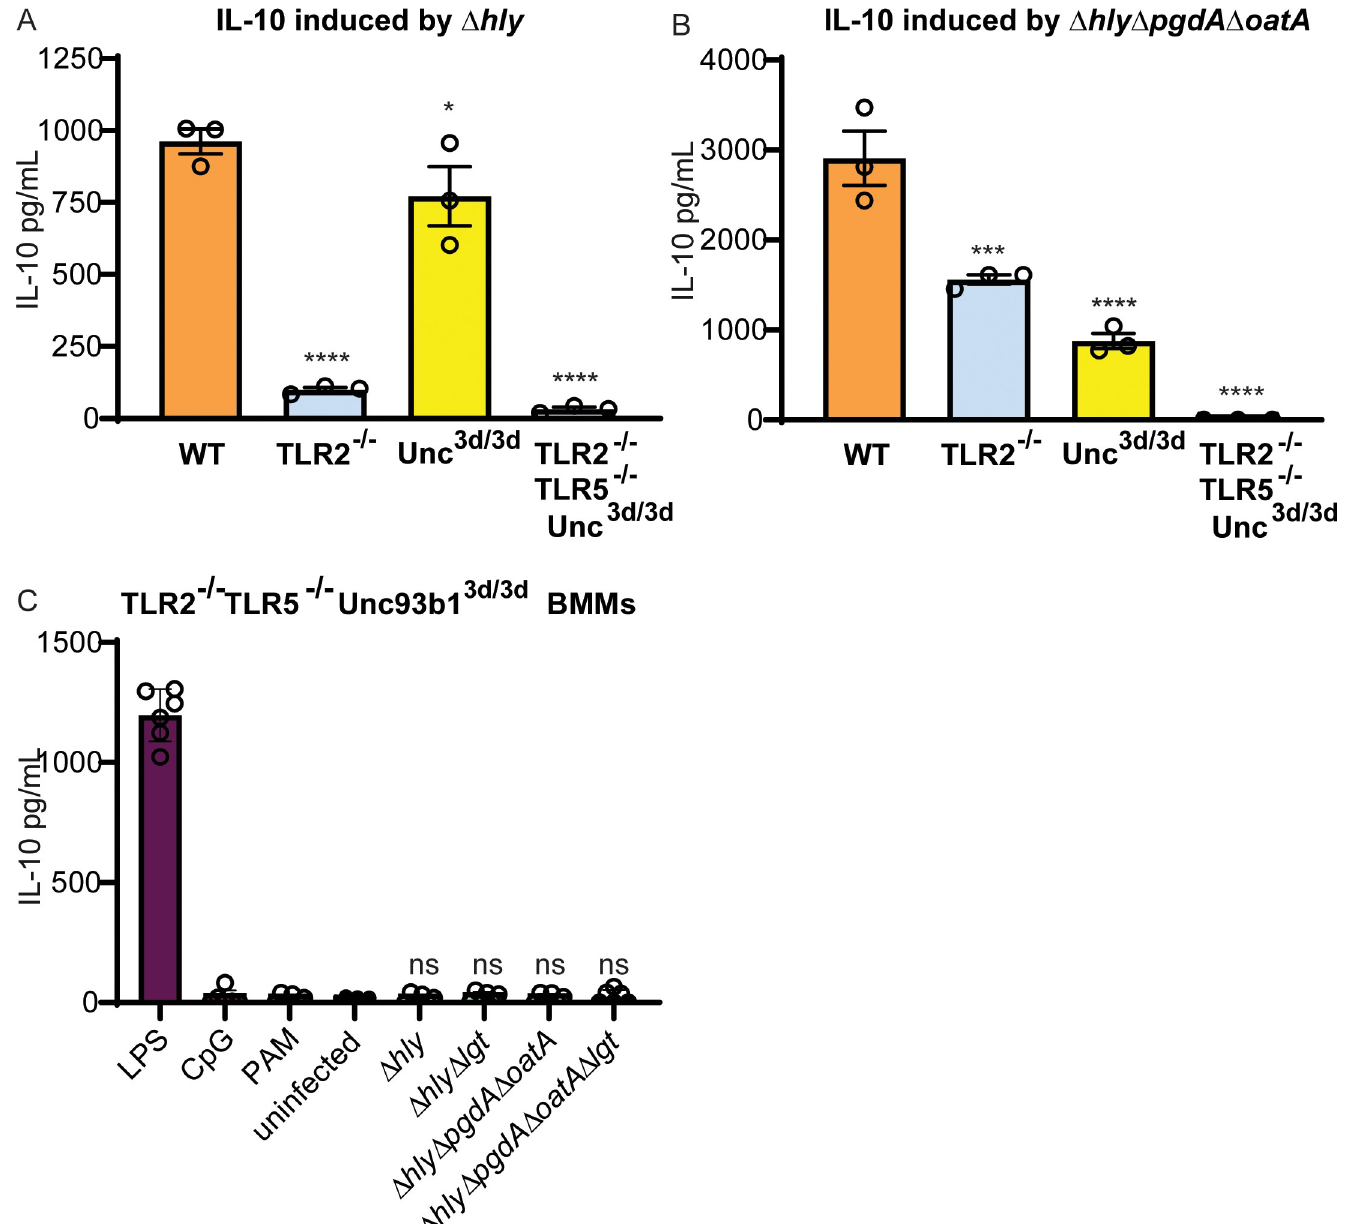
Fig 3. IL-10 secretion from BMMs in response to L . monocytogenes infection requires TLR2 and endosomal TLR signaling. (A) WT, TLR2 -/- , Unc93b1 3d/3d , and TLR2 -/- TLR5 -/- Unc93b1 3d/3d BMMs were infected with Δ hly L . monocytogenes . Cell supernatant was harvested four hours post infection and IL-10 was measured by ELISA. Data shown are representative of two independent experiments. Means were compared to WT using Holm-Sidak’s Multiple Comparisons test. (B) WT, TLR2 -/- , Unc93b1 3d/3d , and TLR2 -/- TLR5 -/- Unc93b1 3d/3d BMMs were infected with Δ hly Δ pgdA Δ oatA L . monocytogenes . Cell supernatant was harvested four hours post infection and IL-10 was measured by ELISA. Data shown are representative of two independent experiments. Means were compared to WT using Holm-Sidak’s Multiple Comparisons test. (C) TLR2 -/- TLR5 -/- Unc93b1 3d/3d BMMs were infected with the indicated strains of L . monocytogenes , or treated with lipopolysaccharide (LPS), a TLR4 agonist; CpG ODN 1668 (CpG), a TLR9 agonist; or Pam2CSK4 (PAM), a TLR2 agonist. Data shown are pooled from two independent experiments. Data analyzed using Holm-Sidak’s Multiple Comparisons test.